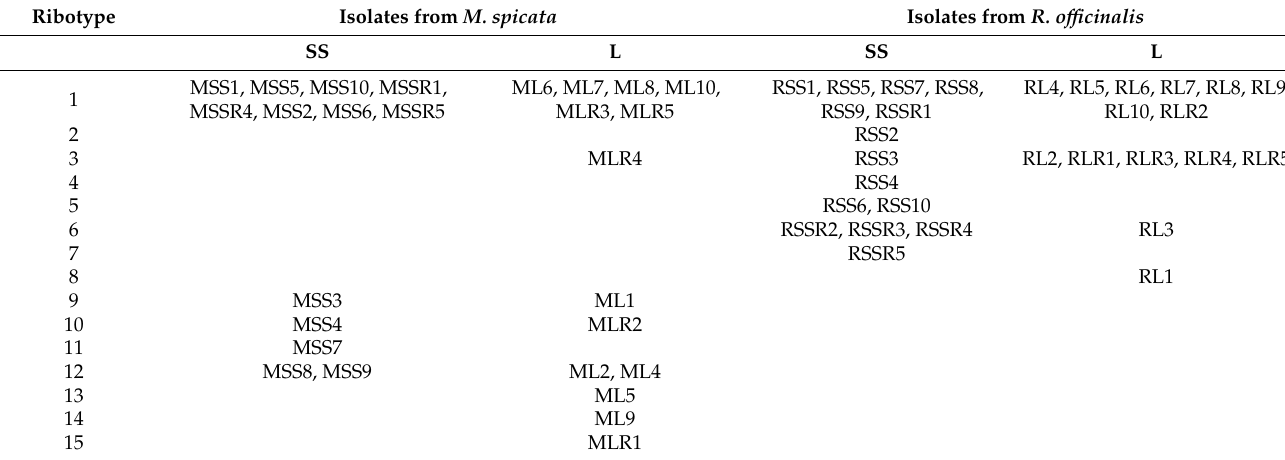
Table 5. Ribotypes of bacteria isolated from hydroponic system in M. spicata and R. officinalis plants. Ribotype